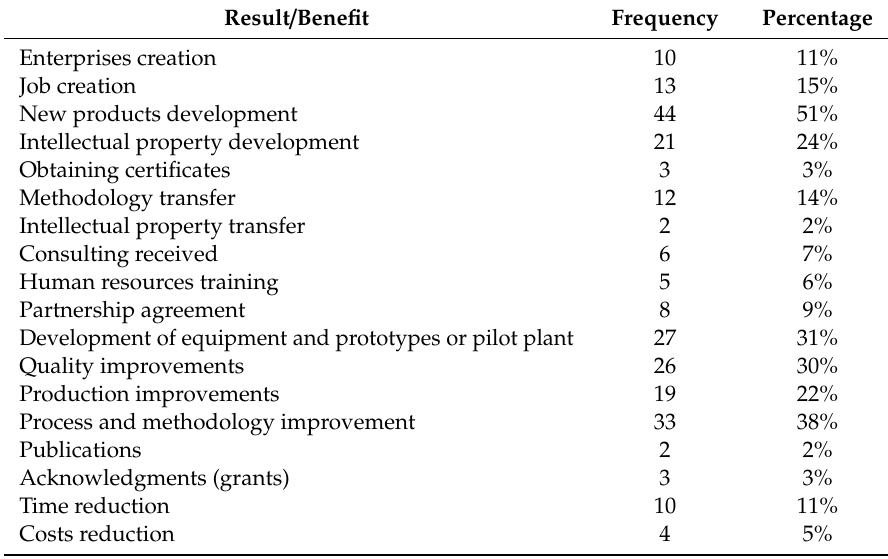
Table 4. Results / Benefits identified from the 87 analyzed TKT